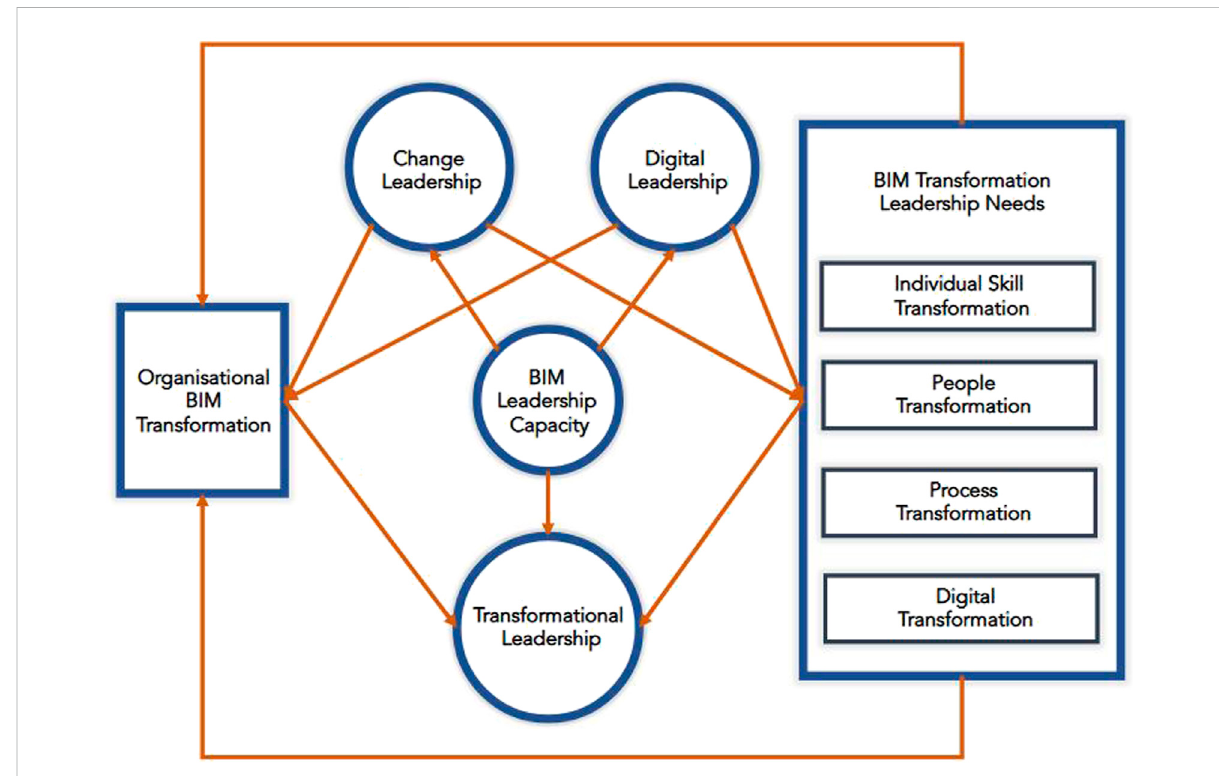
FIGURE 3 Theoretical framework of BIM leadership for organisational BIM